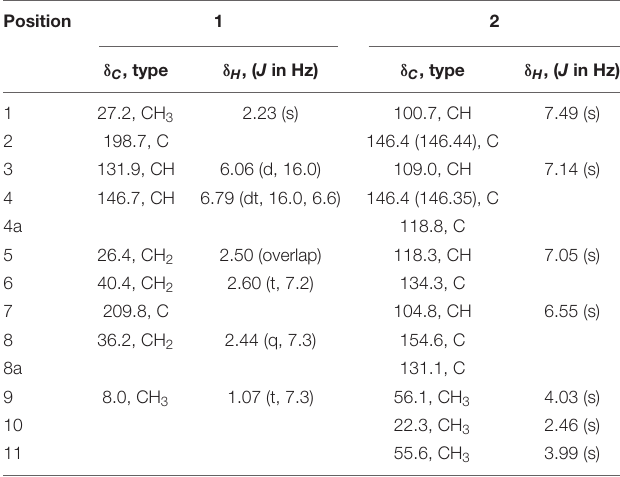
may have been passed down from ancestors to